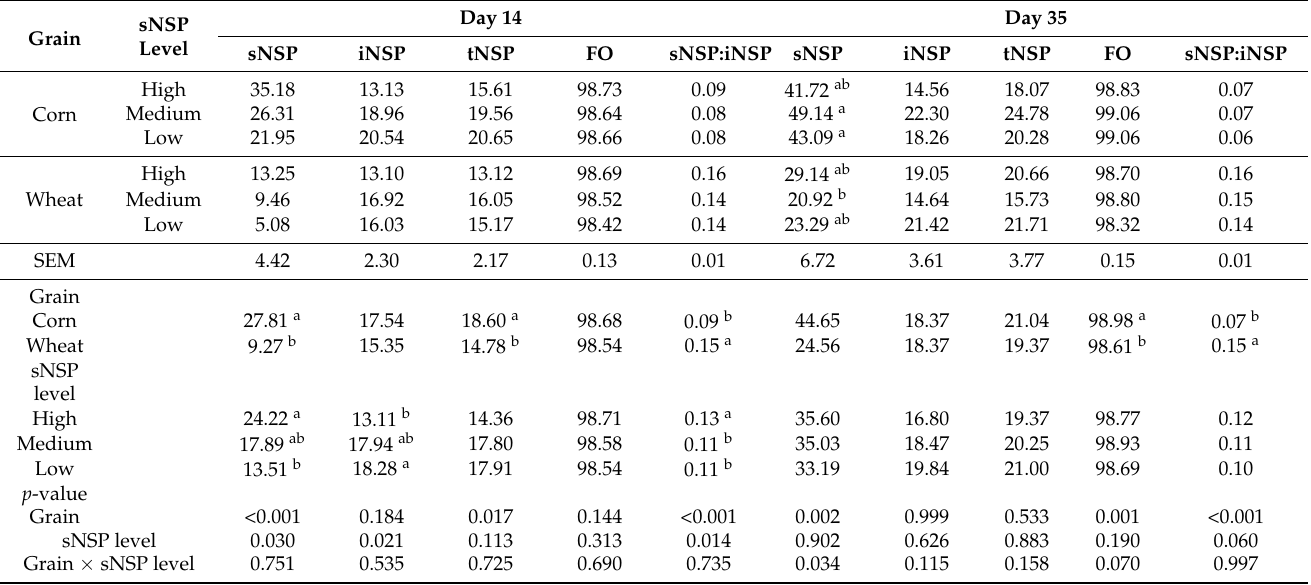
Table 9. Effect of dietary soluble non-starch polysaccharide (sNSP) level and grain source on apparent disappearance of soluble (sNSP), insoluble (iNSP), and total NSP (tNSP) and free oligosaccharides (FO) (%) and ratio of soluble to insoluble non-starch polysaccharide (sNSP:iNSP) in the excreta in broilers at d 14 and 35.